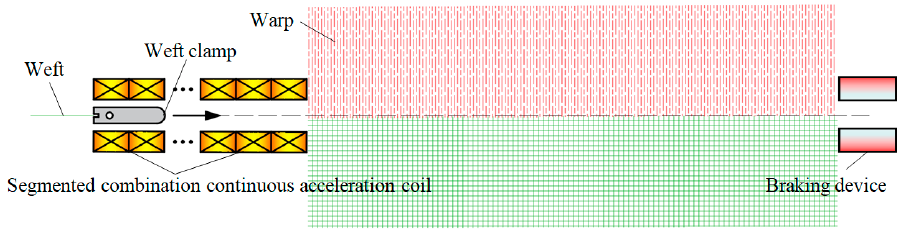
Figure 2. Principle diagram of multi-stage intermittent electromagnetic weft insertion.